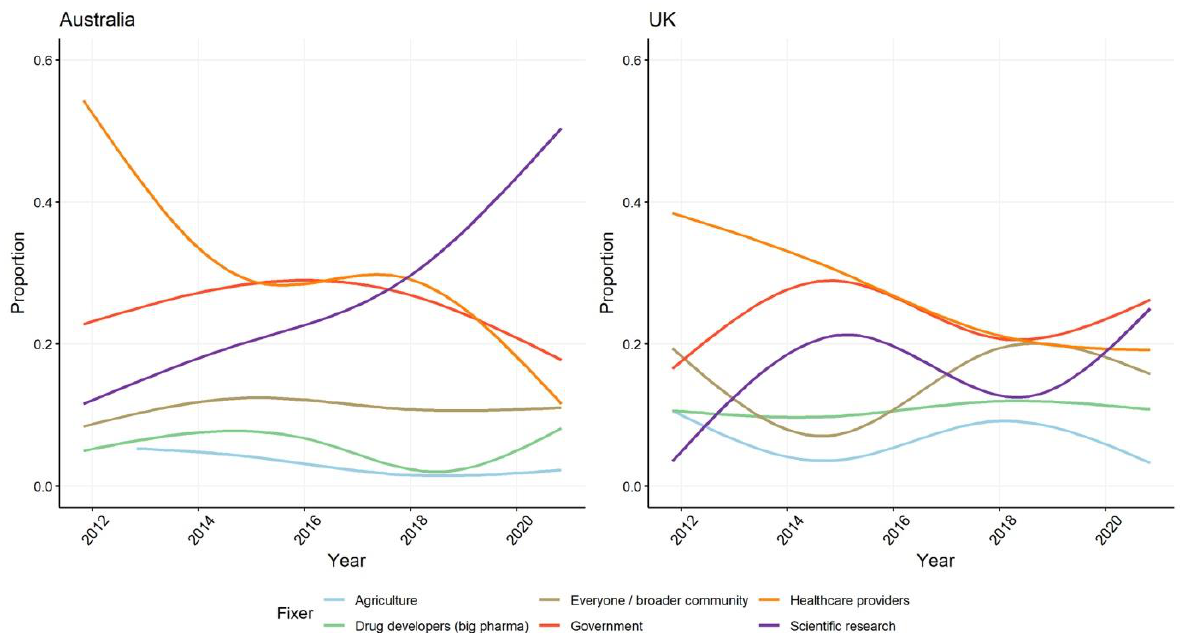
Figure 8. Proportion of different framings in Australian and UK newspapers of who is responsible for fixing the problem of AMR.